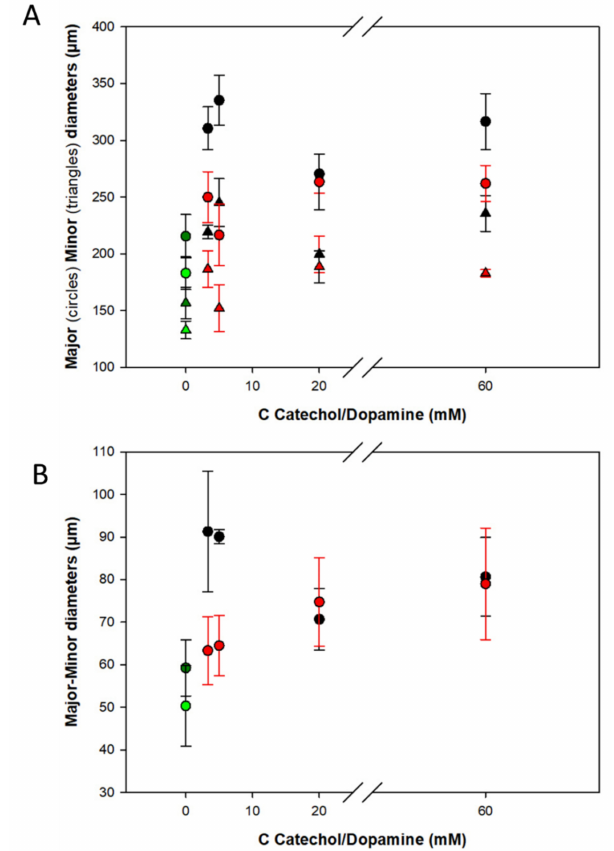
Figure 7. ( A ) Major (circles) and minor (triangles) pore diameters of freeze-dried samples as a function of phenolic compound concentration. ( B ) Difference between the major and the minor diameters taken from Figure 5A. G 10 (dark green), G 10 N 10 (green), and the catechol- (black) and dopamine-containing (red)